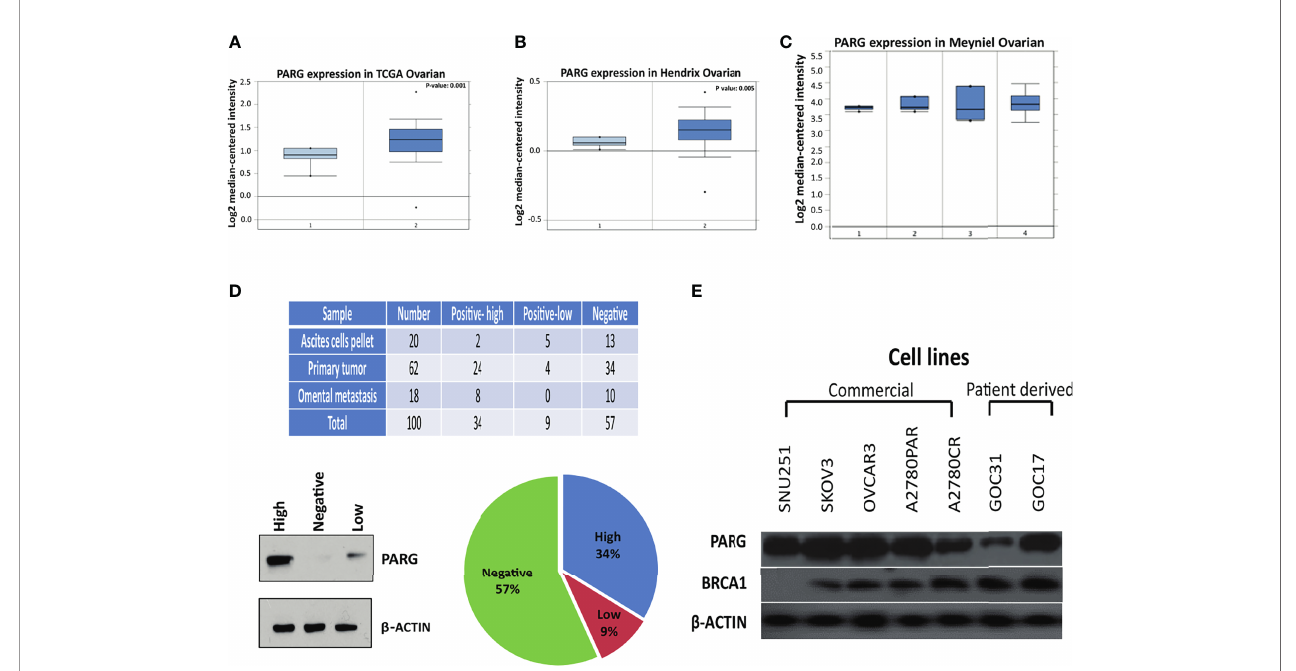
FIGURE 2 | PARG is over expressed in ovarian cancer. PARG mRNA expression was evaluated in normal and malignant ovarian samples using three different datasets: the TCGA dataset (1- Normal ovary (n-8), 2 – Ovarian serous carcinoma (n-586)) (A) and the Hendrix dataset (1- Normal ovary (n-4), 2 – Ovarian serous carcinoma (n-41)) (B) , and the Meyniel dataset (1- Clear cell carcinoma (n-6), 2- Endometroid carcinoma (n-6), 3- mucinous carcinoma (n-7), 4- Serous carcinoma (n- 71)) (C) . PARG protein levels were evaluated by western blot in 100 high grade serous ovarian cancer tumors kept in our biobank. PARG representative western blot for each level category (low, high, and negative). The level category was set according to the intensity of the western blot band while OVCAR3 protein extract was used as a positive control. (D) . Expression of PARG and BRCA1 proteins were examined by western blot (E) in commercial (SNU251, SKOV3, OVCAR3, A2780PAR, A2780CR) and patients derived (GOC17, GOC31) cell